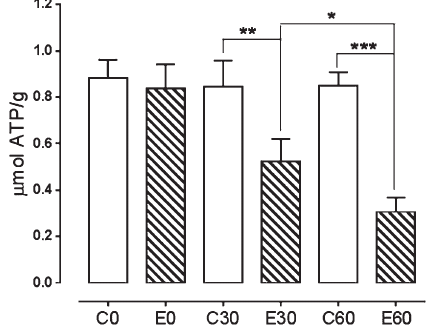
Figure 6. Effect of eugenol on ATP concentration of rat atria. The concentrations of ATP were measured in the absence ( C ) and in the presence ( E ) of eugenol at 0, 30, and 60 min. Data are reported in m mol ATP/g protein. P , 0.05 (ANOVA followed by the Student t -test): *E30 vs E60; **C30 vs E30; ***C60 vs